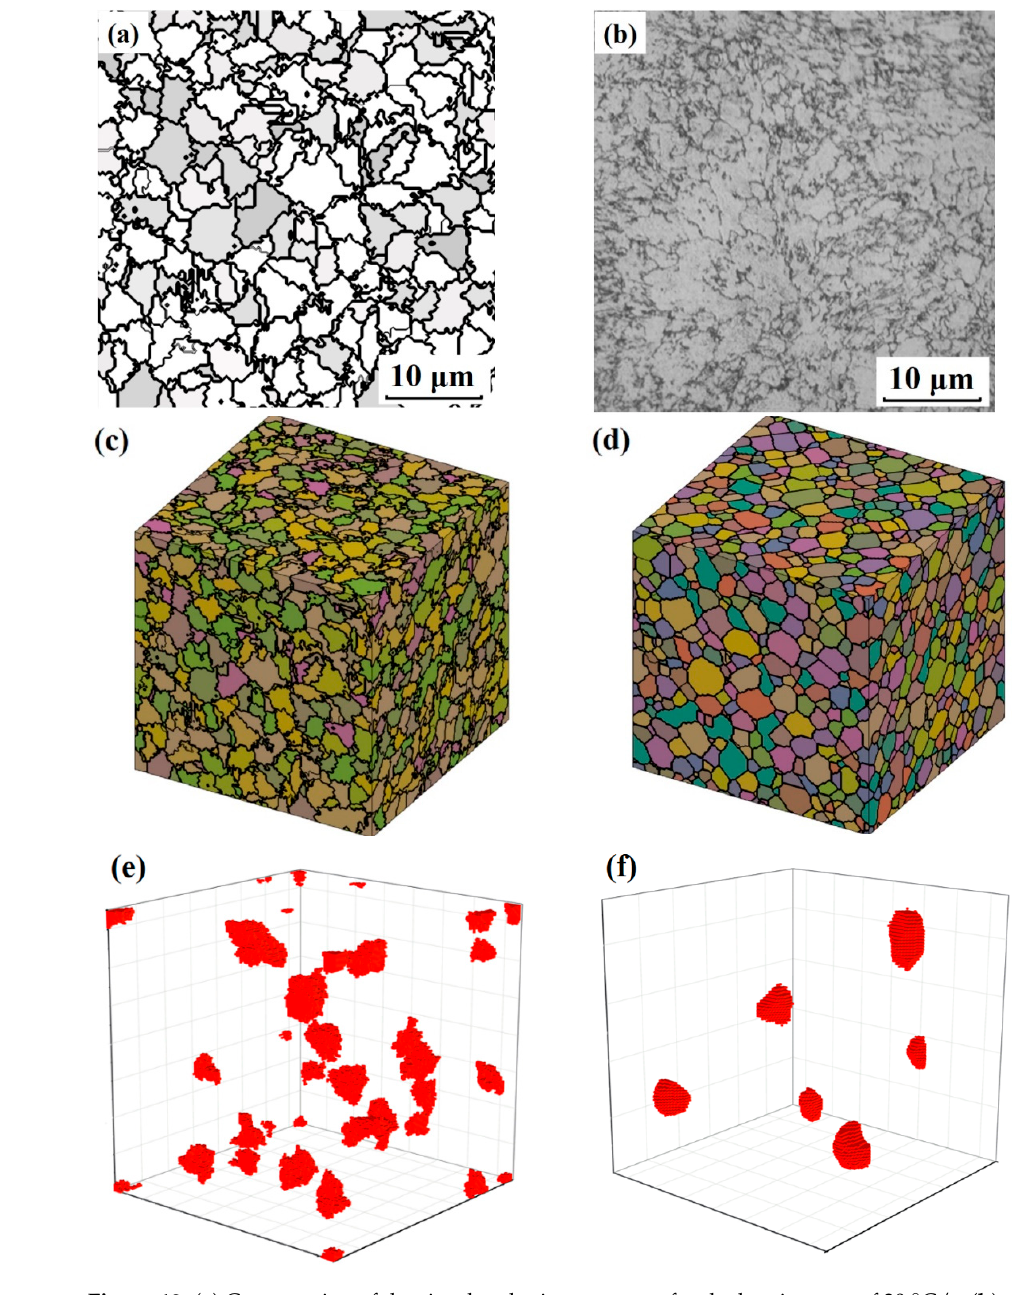
Figure 10. ( a ) Cross section of the simulated microstructure for the heating rate of 30 °C/s; ( b ) optical micrograph of the austenite microstructure after rapid heating and cooling; ( c ) simulation results of the 3D microstructure for 30 °C/s; ( d ) 3D normal grain microstructure simulated with classical Monte Carlo model; ( e ) 3D single grains drawn from ( c ); ( f ) 3D single grains drawn from ( d ).